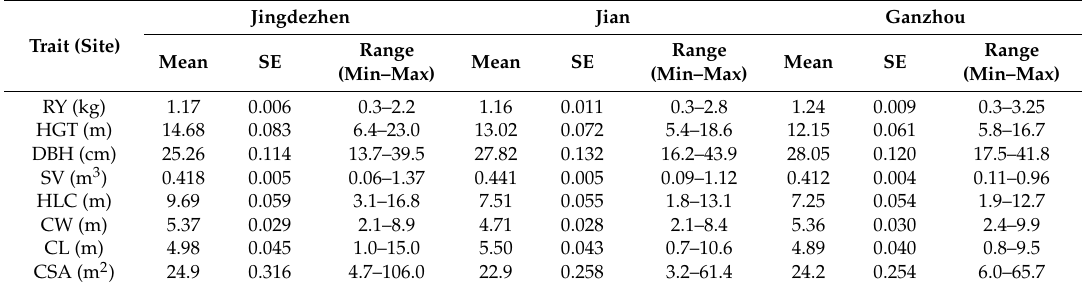
Table 2. Mean values, standard error of the mean (SE) and range of variation based on individual values of the resin yield, growth traits and morphologic traits of P. elliottii for the three progeny trials. Jingdezhen Trait (Site)